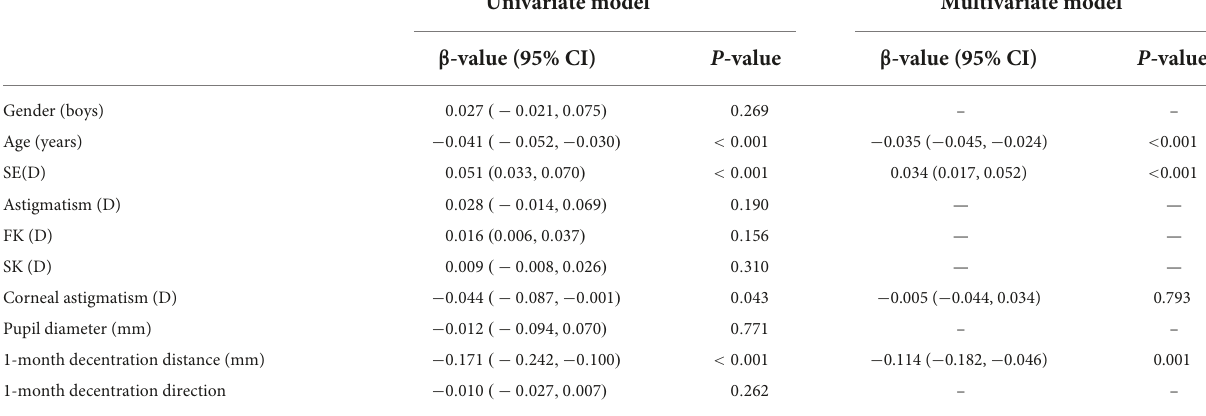
TABLE 3 Linear regression analyses of 12-month ALG and individual